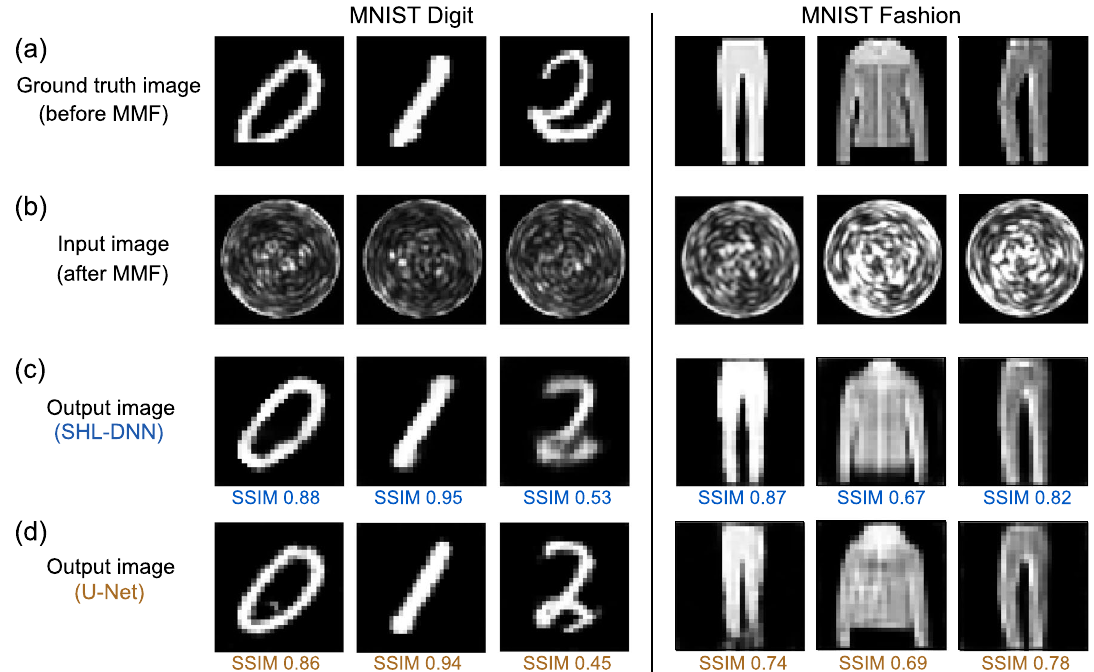
Figure 2. Demonstration of MMF image reconstruction on the MNIST digit dataset (first three columns) and the MNIST-Fashion dataset (last three columns). ( a ) A representative sample of 28 × 28 ground truth images. ( b ) The corresponding 64 × 64 images obtained from the MMF. ( c ) Reconstructed 28 × 28 images produced by the SHL-DNN. The structural similarity (SSIM) relative to the ground truth image is shown below each reconstructed image. ( d ) The corresponding results produced by the